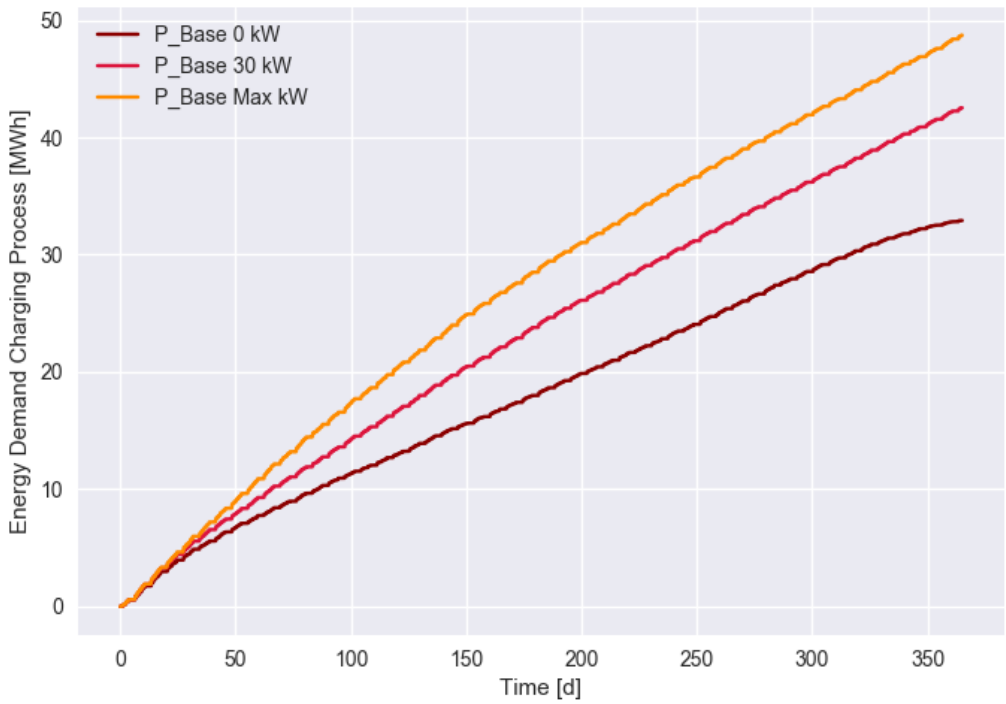
Figure 4. Accumulated charging energy over time for different values of P Base for the CSI scenario.